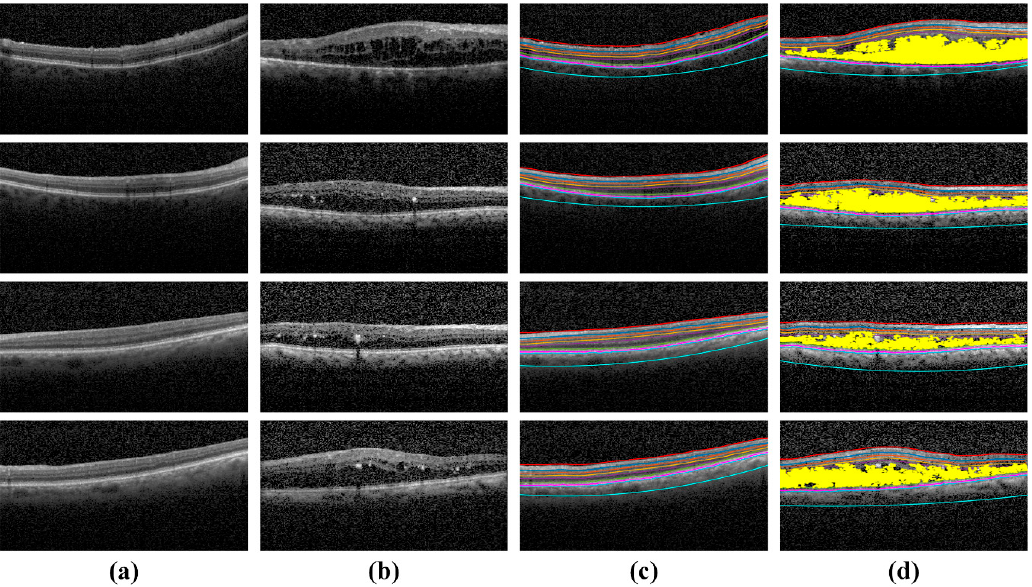
Figure 13. Healthy and ME OCT scans in the Rabbani dataset [36], which are processed by the proposed system. ( a ) Original healthy OCT B-scans; ( b ) original ME OCT B-scans; ( c ) classified as healthy by the proposed system and ( d ) classified as ME by the proposed system.